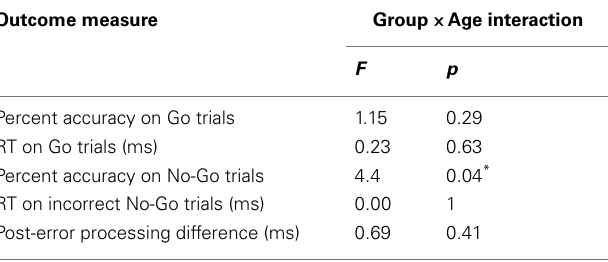
Table 2 |Age effects on Go/No-Go